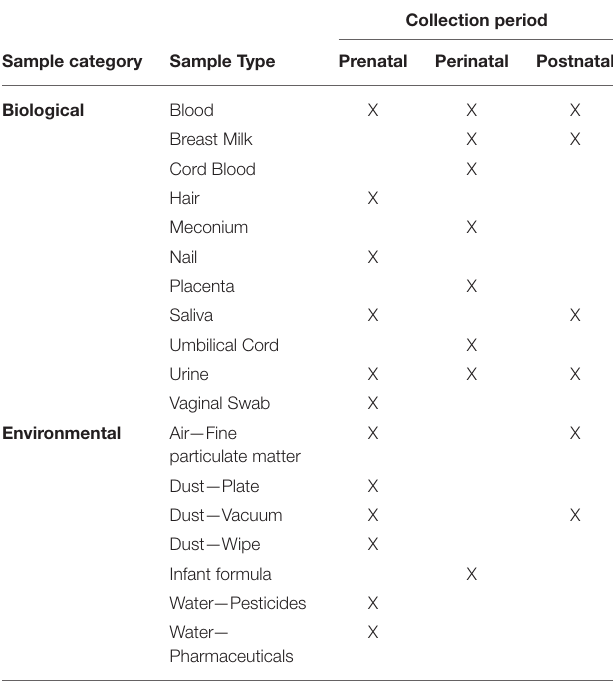
TABLE 5 | NCS Biospecimen and Environmental Samples available by Collection Period.